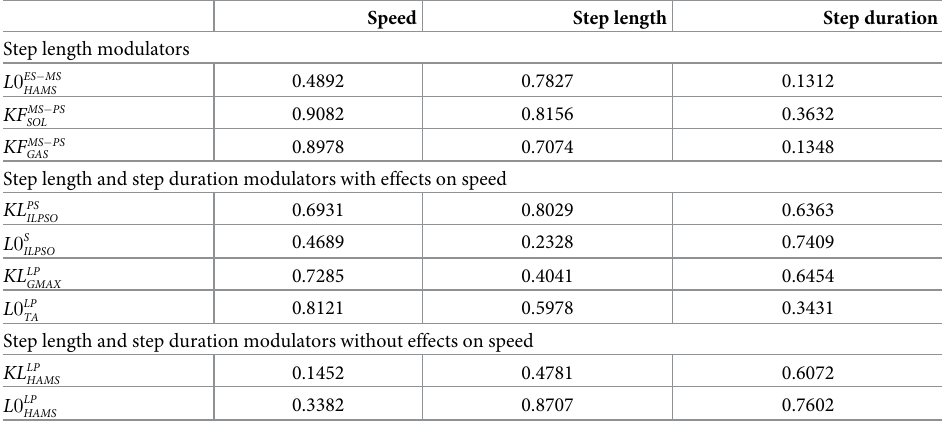
Table 3. Correlation coefficients of identified key reflex parameters: Three reflexes were found to have a signifi- cant effect on speed through the modulation of step length, four to have an impact on all the three gait character- istics, and two able to modulate step length and step duration accordingly with small effects on